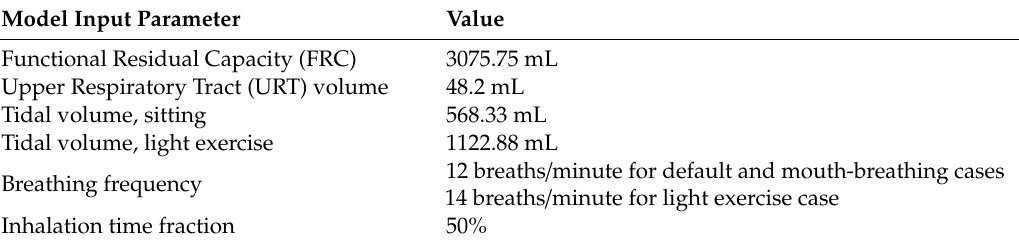
Table 1. Breathing parameters used in model runs.